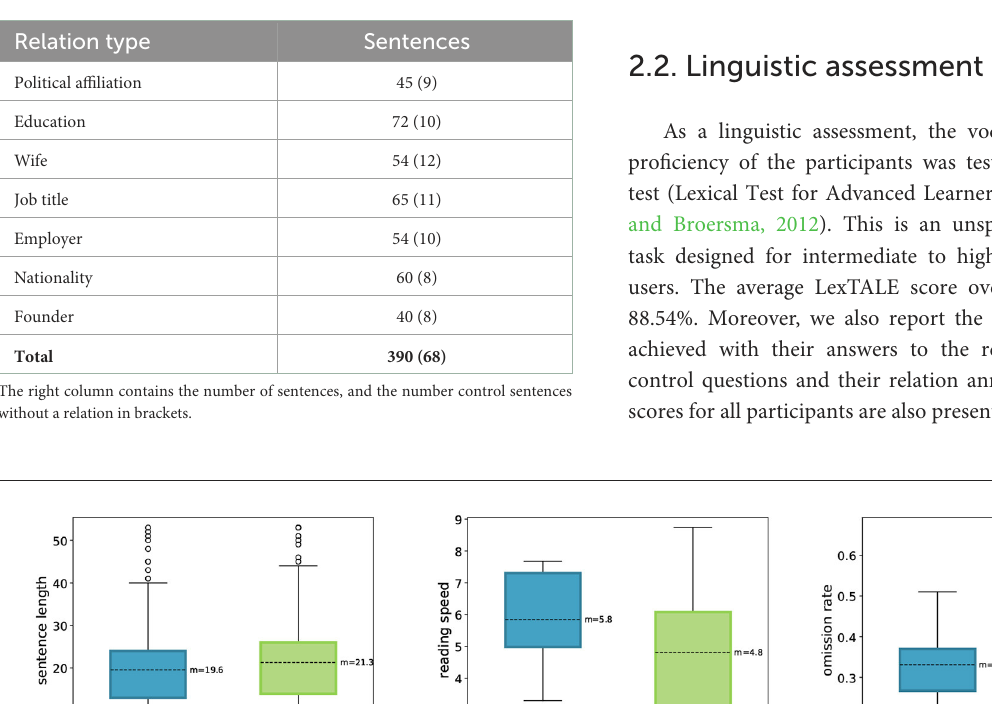
TABLE 2 Distribution of relation types in the task-specific reading.